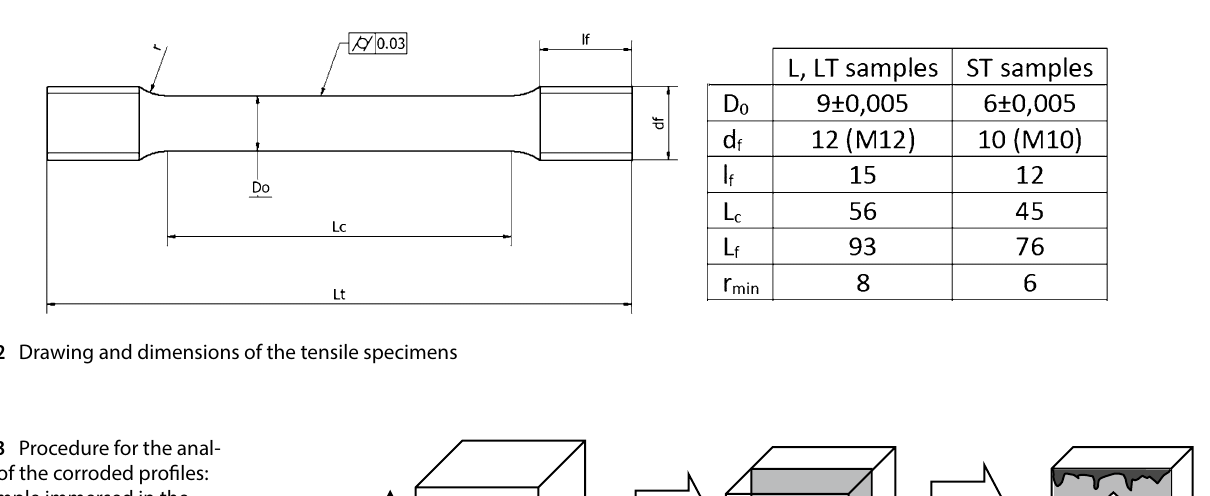
Fig. 3 Procedure for the anal- ysis of the corroded profiles: a sample immersed in the testing solution; b cut along the L-ST plane; c observed corroded profile